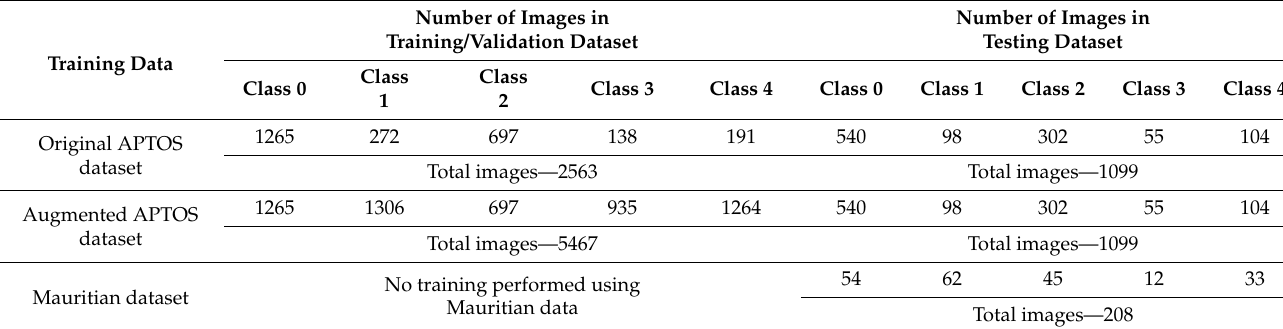
Table 1. Number of images class-wise in the 3